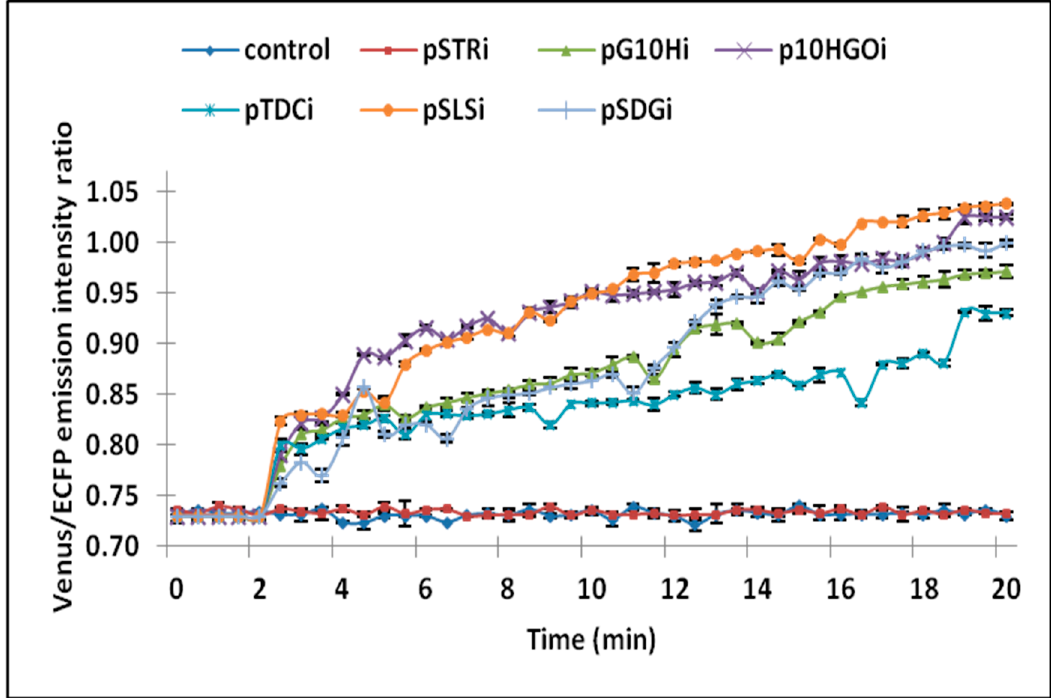
Figure 4. Confocal microscopy analysis, representing increased FRET ratio after 2.5 min in the elicited single cells harbouring pG10Hi, p10HGOi, pTDCi, pSLSi, and pSDGi. No significant FRET ratio change was seen in pSTRi-containing cell. Values are mean of three independent replicates. Vertical bars represent the standard